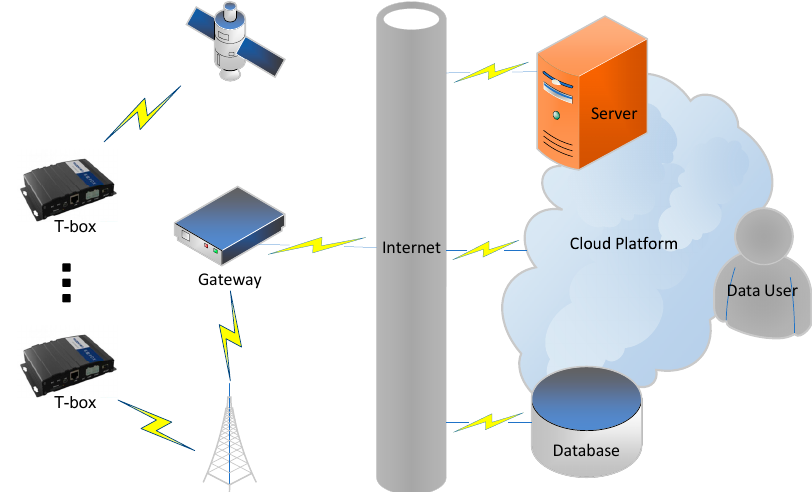
Figure 1. Schematic diagram of data acquisition, transmission, storage and application.